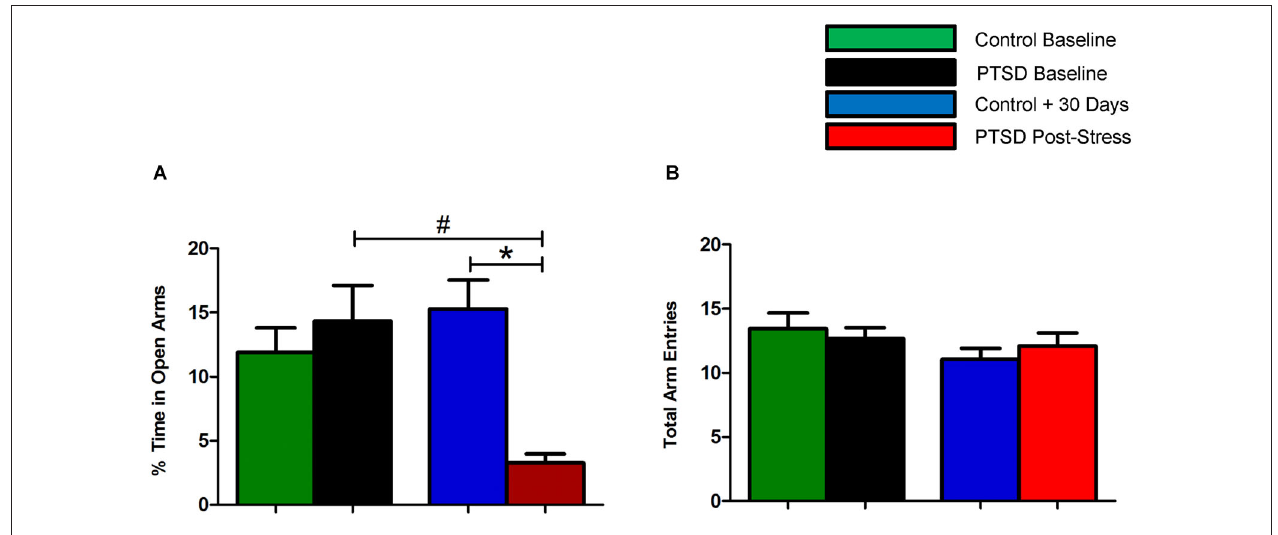
were no differences noted in overall ambulations between or within groups (B) . All data are presented as mean ± SEM. * p < 0.05 relative to the control group. # p < 0.05 relative to within group measurements (baseline).